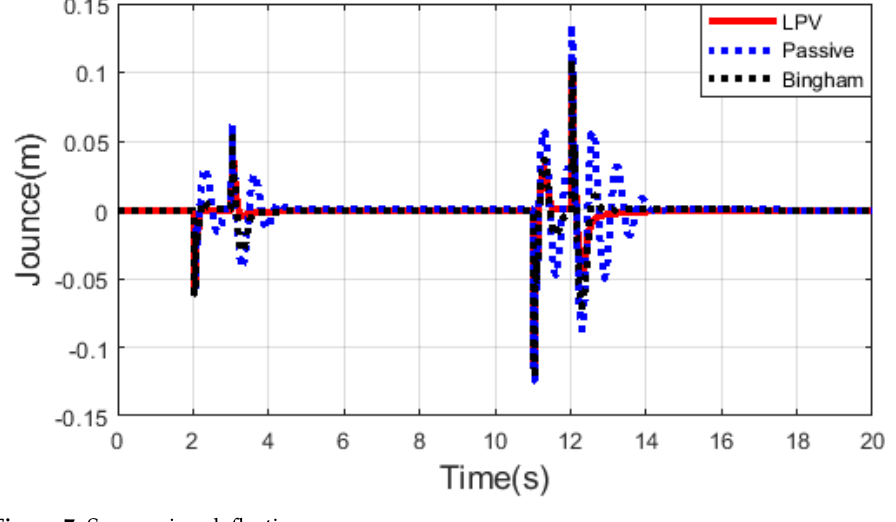
Figure 7. Suspension deflection.